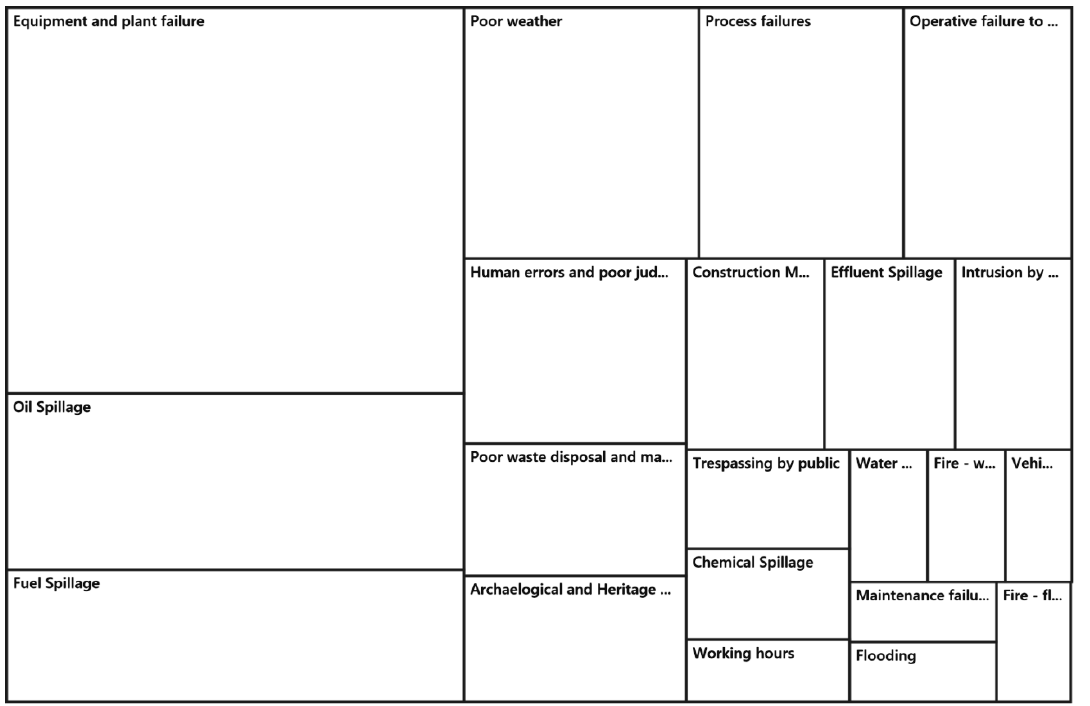
Figure 4. Tree map analysis – compared by number of coding references